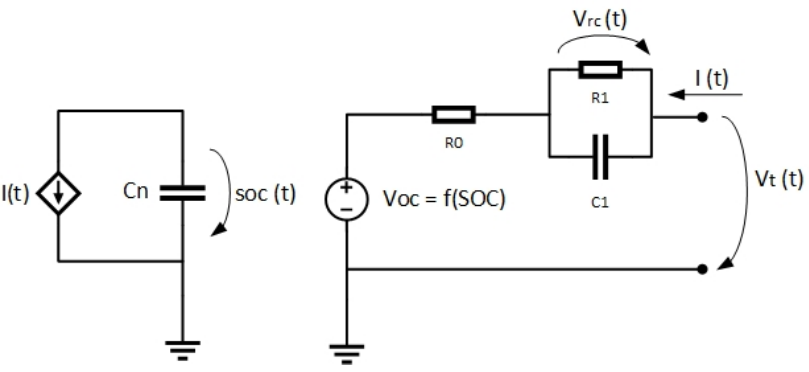
Figure 1. Equivalent circuit battery model.